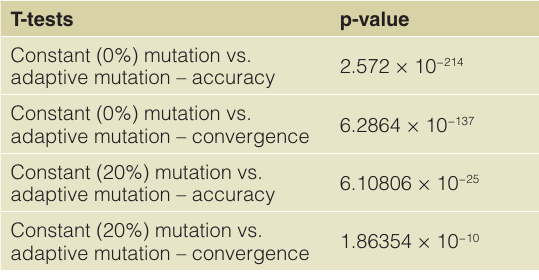
Figure 6. 3D maximization accuracy and convergence results for constant and adaptive mutation rate genetic algorithms. A . This is a graph of the 3D surface maximization problem accuracies among 0% constant mutation, 20% constant mutation, and adaptive mutation. B . This is a graph of the 3D surface maximization problem convergences among 20% constant mutation and adaptive mutation. 0% constant mutation was not statistically analyzed because convergence was not achieved. ***p < 0.001. mutation (mut.), adaptive (adapt.). Table 3. Summary of statistical tests on N-queens results comparing the accuracies and convergence generations associated with adaptive and constant mutation rates.